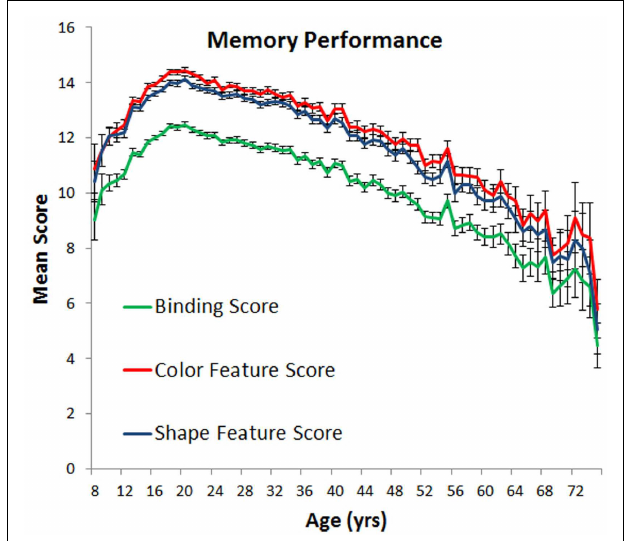
FIGURE 3 | Mean number of objects remembered (with standard error) as a function of